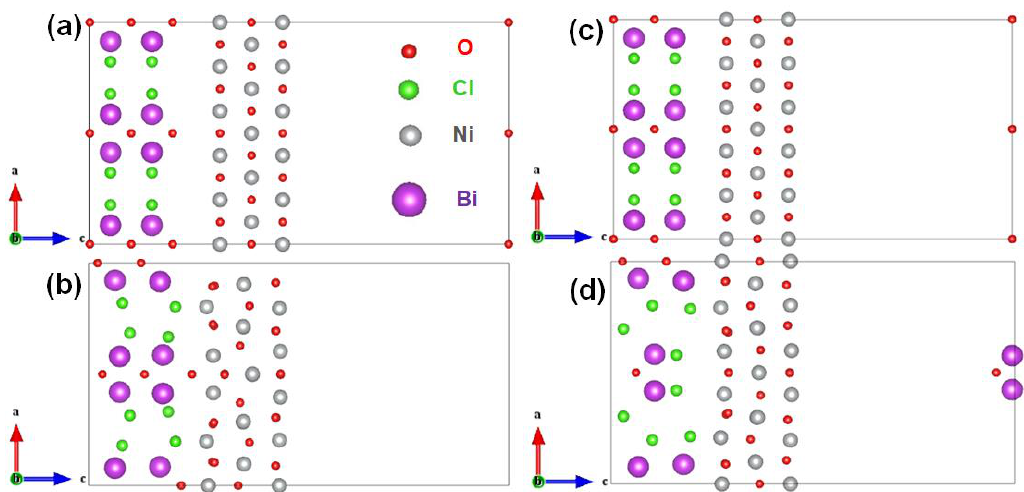
Figure 3. The heterojunction structures of the NiO-100 and BiOCl-110 surfaces. The NiO(100)-O(BiOCl-110) heterostructure: ( a ) initial structure, ( b ) DFT-optimized structure. The NiO(100)-BiCl(BiOCl-110) heterostructure: ( c ) the initial structure, ( d ) DFT-optimized structure.